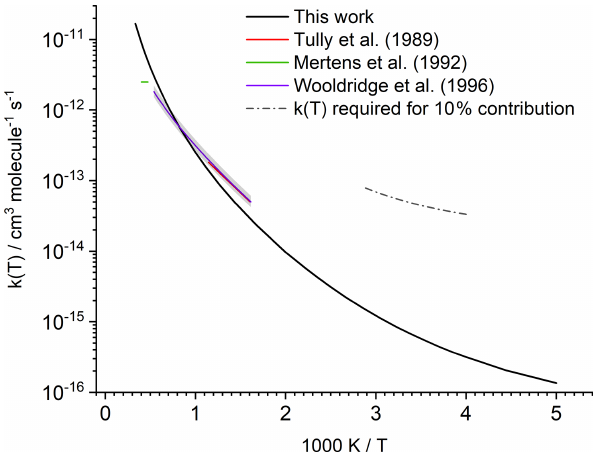
Figure 3. Total rate coefficient predictions for the reaction of HNCO with NO 3 , Cl, and O 3 . The addition of Cl atoms on HNCO leads to the formation of a very short-lived adduct, which rapidly re- dissociates to the reactants; the effective rate coefficient for HNCO loss by Cl atoms, k eff (Cl), is thus equal to the H-abstraction rate forming HCl + NCO (see